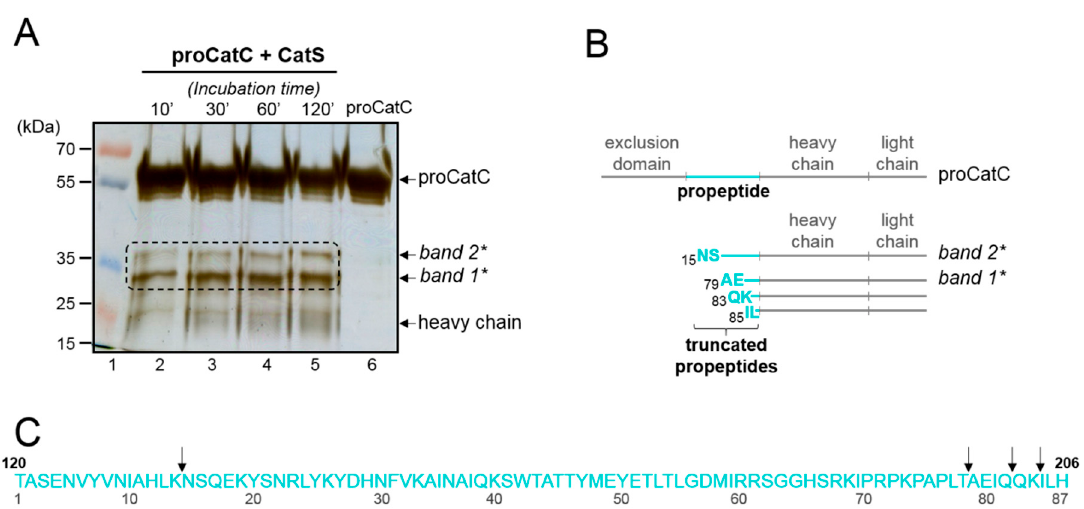
Figure 1. Wt-proCatC maturation by CatS. ( A ) ProCatC (50 µ M) processing by CatS (1 µ M) in vitro. The progress of the processing was analyzed after 10 min (lane 2), 30 min (lane 3), 60 min (lane 4), and 120 min (lane 5) by SDS-PAGE and silver staining. Molecular mass standards and control of proCatC are shown in lanes 1 and 6, respectively. ( B ) Structure of proCatC and cleavage products carrying truncated propeptides at the N-terminus after the initial cleavages of proCatC by CatS. The N-terminal residues of band 2* and band 1* were identified by Edman sequencing. Band 2* and band 1* contain heavy and light chains, as shown in Reference [18]. ( C ) Amino acid sequence of the CatC propeptide (residues 120–206) in single letter code. Arrows indicate the processing sites of CatS, as determined by Edman sequencing of band 2* and band 1.